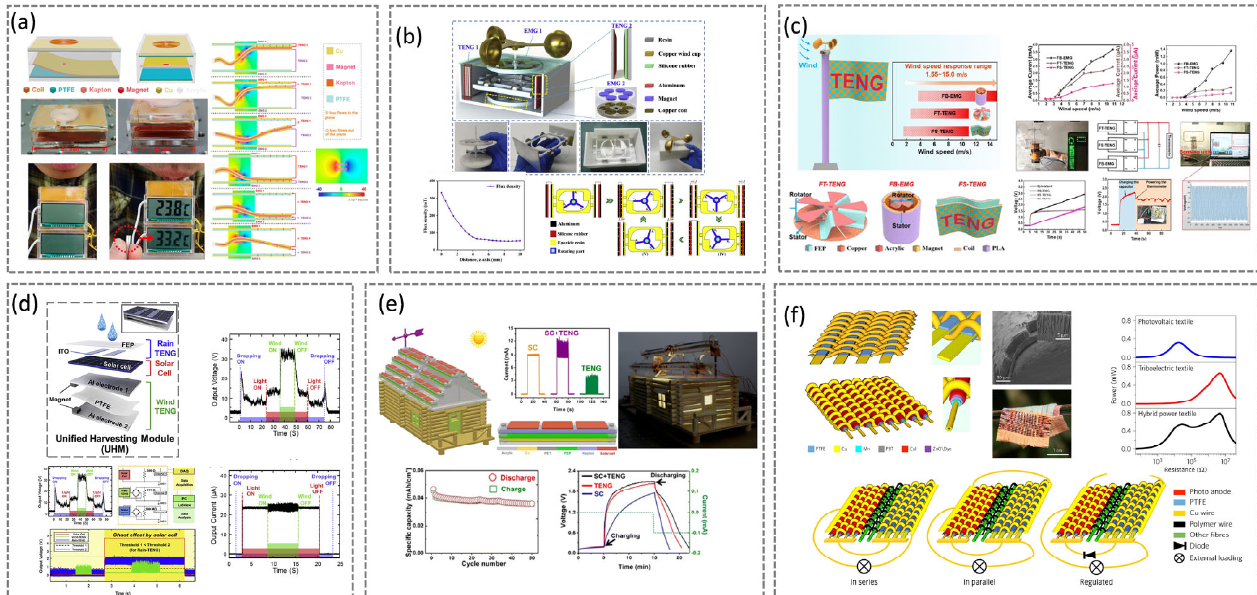
Figure 7. WD ‐ TENG hybridized with other generators: ( a – c ) schematic illustration of the hybrid nanogenerator. (TENGs and EMGs) (reproduced with permission [59]. Copyright 2015, ACS Nano ); (reproduced with permission [60]. Copyright 2019, Nano Energy ); (reproduced with permission [61]. Copyright 2021, ACS Energy Letters ). ( d – f ) Hybrid TENGs combined with SCs and TENGs for scavenging wind energy (reproduced with permission [62]. Copyright 2020, Nano energy ); (reproduced with permission [63]. Copyright 2016, Nature Energy ); (reproduced with permission [64]. Copyright 2018, Nano energy ).